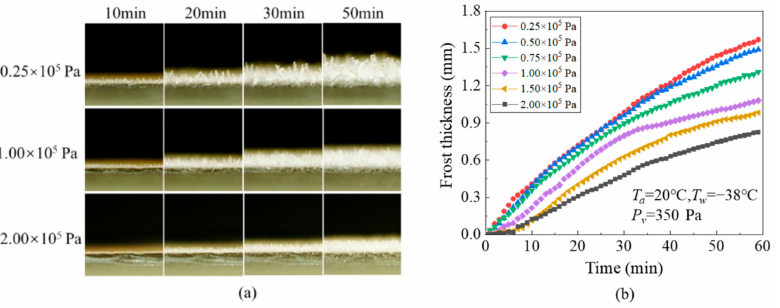
Figure 6. Frost thickness under different working pressures around the cooling surface with time: ( a ) Photos; ( b ) diagram of frost